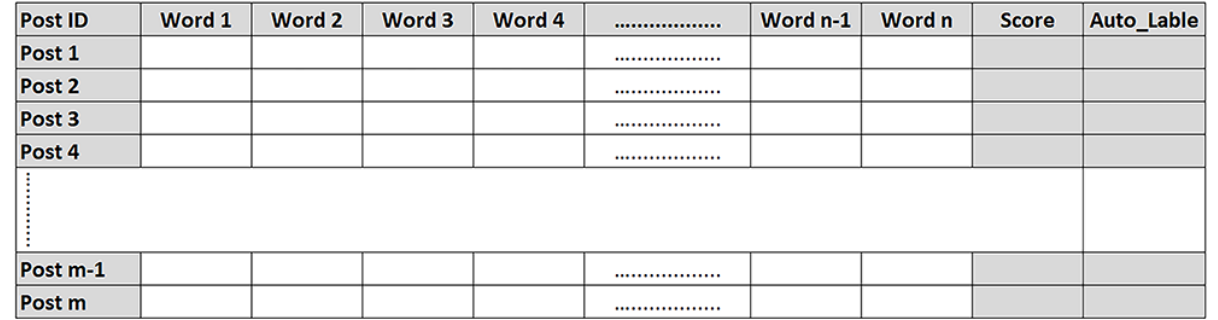
Figure 3. Evaluation matrix for users’postquality